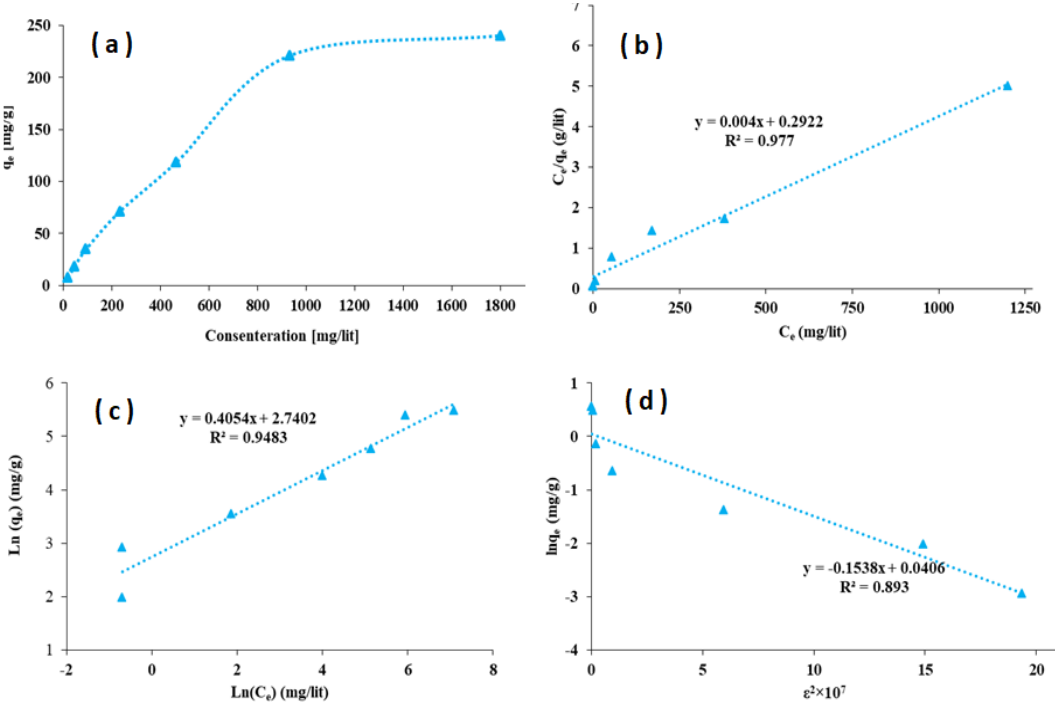
Fig. 8. (a) uptake of Cs(I) at various initial concentrations,(b)straight-line plot of Langmuir model, (c) straight-line plot of Freundlich model, (d) straight-line plots of Dubinin– Radushkevich